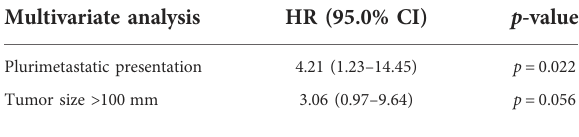
TABLE 4 Multivariate Cox regression model for the overall survival